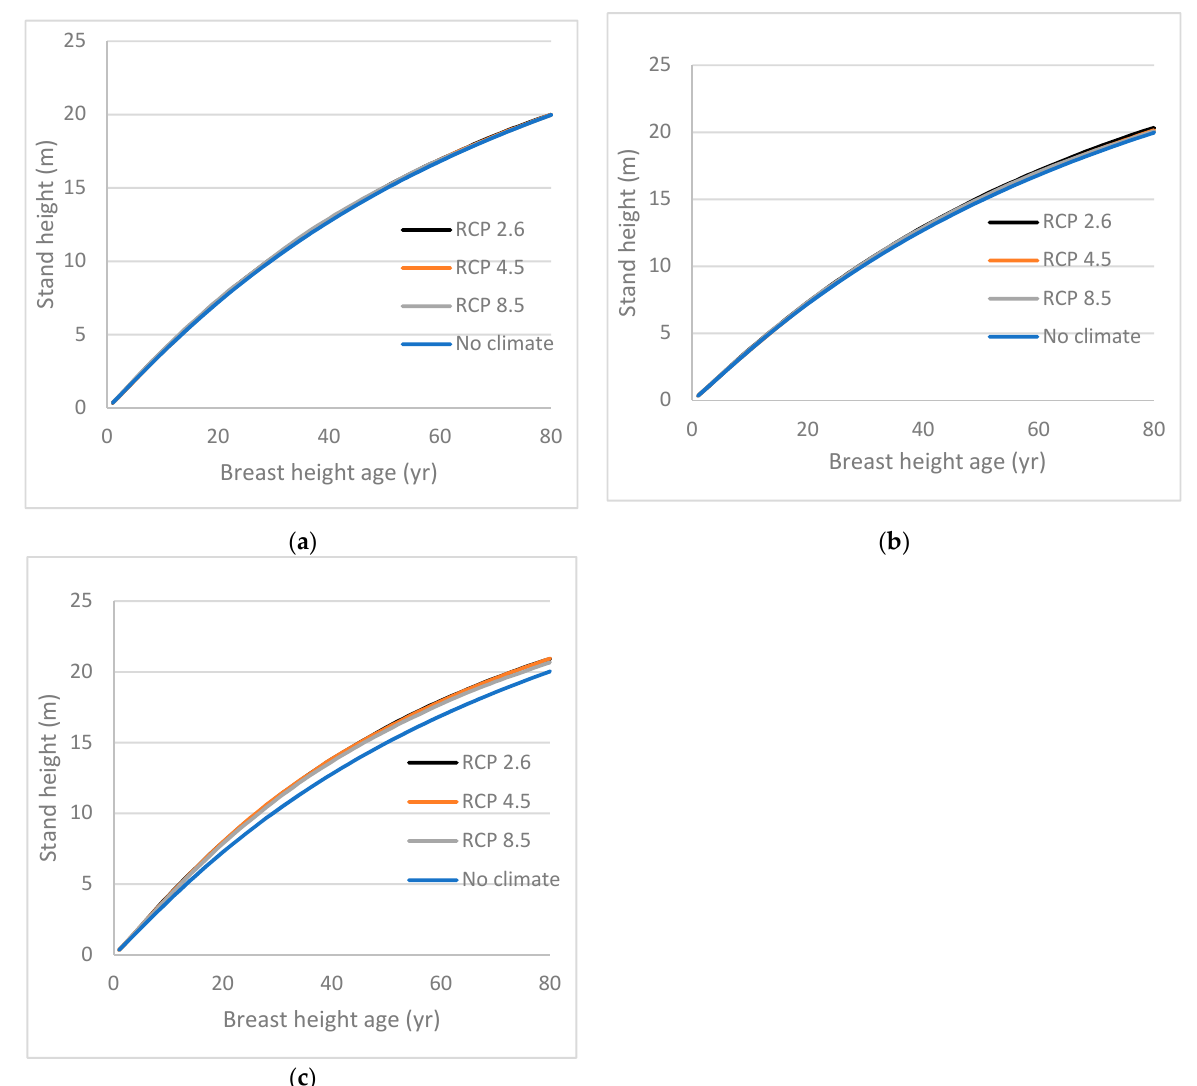
Figure 2. Stand height profiles for jack pine trees generated using projected values of climate variables for the period 2021 to 2080, assuming climate remains stable (no climate) or warms (RCPs 2.6, 4.5, and 8.5), in Equation (2) for ( a ) eastern (near Sudbury), ( b ) central (near Hearst), and ( c ) western (near Dryden) Ontario, Canada. Climate variables were projected for locations close to sample sites using three emissions trajectories known as representative concentration pathways (RCPs).